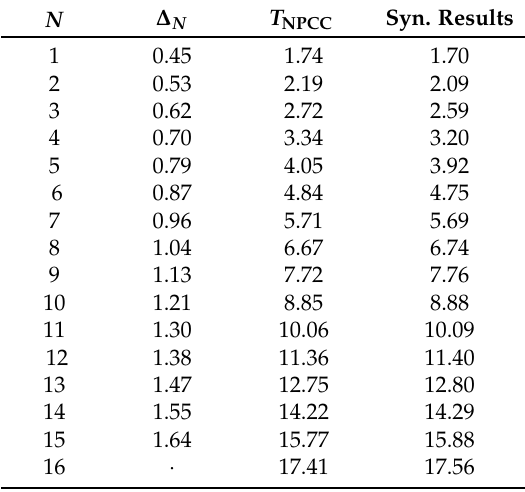
Table 1. Propagation delay estimates (ns) of an N -stage, 16-bit non-pipelined-cascaded CORDIC (NPCC), and corresponding synthesis results obtained using the TSMC 90 nm CMOS library. N ∆ N T NPCC Syn.